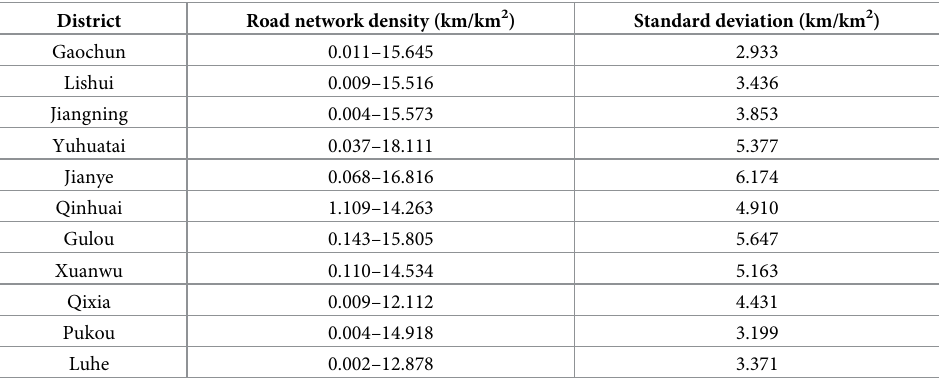
Table 6. Road statistics of each